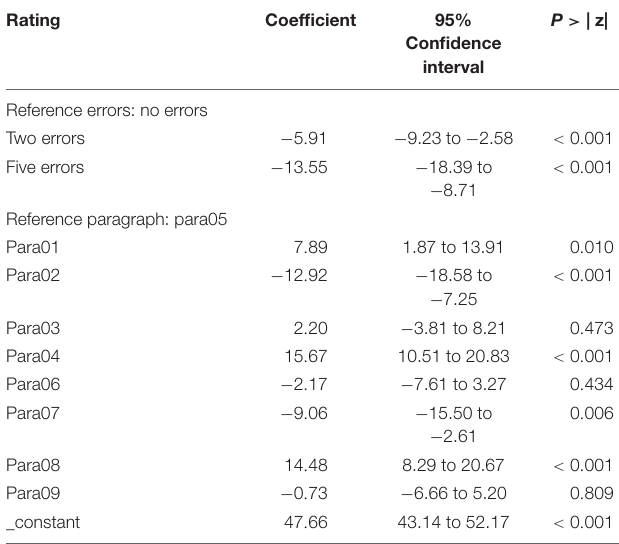
TABLE 2 | Linear mixed effects model for trustworthiness rating (outcome) based on fixed effects of (predictors) error number and paragraph number, with a random effect for volunteer